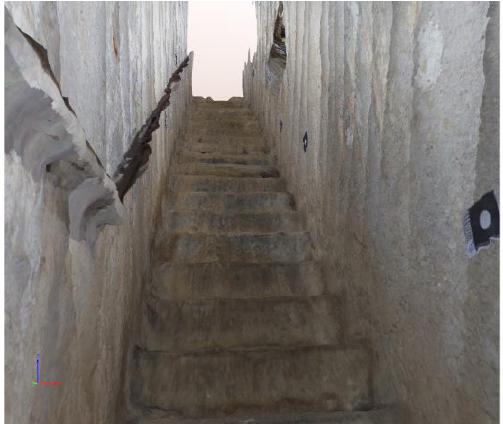
Figure 19: 3D reconstruction result for the fence with